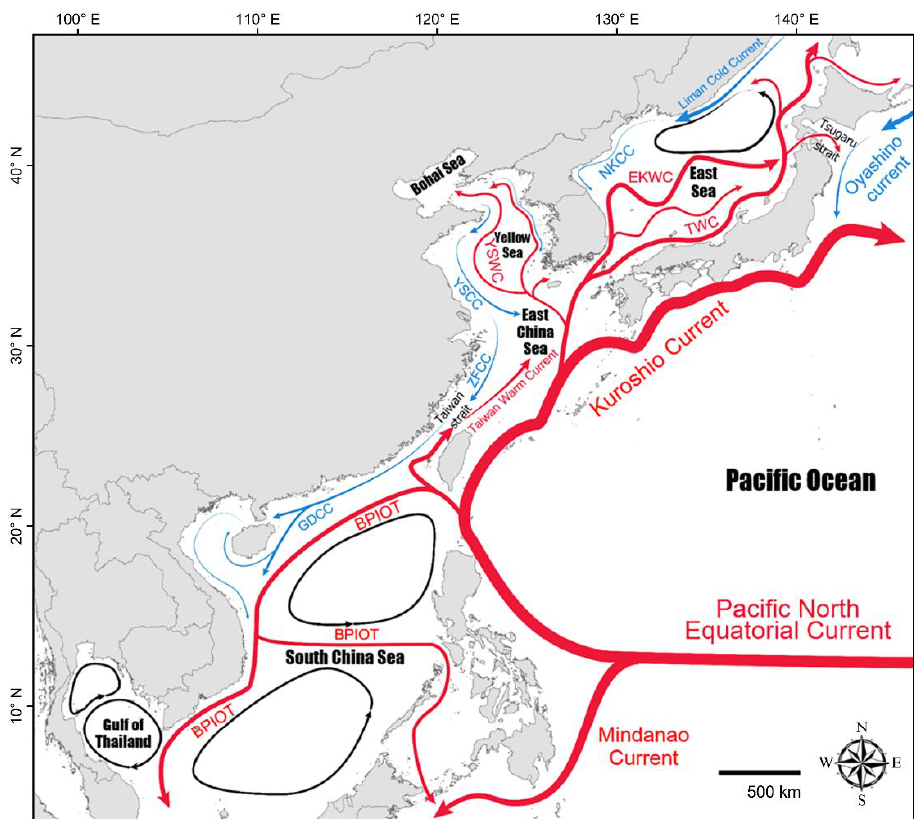
Figure 4. Topography and typical current patterns in the North Pacific Ocean (with reference to References [61 – 63]). Red arrows indicate warm currents, blue arrows indicate cold currents, and black arrows indicate gyres. BPIOT, Branch of the Pacific-to-Indian Ocean Throughflow; EKWC, East Korean Warm Current; GDCC, Guangdong Coastal Current; NKCC, North Korea Cold Current; TWC, Tsushima Warm Current; YSCC, Yellow Sea Coastal Current; ZFCC, Zhejiang-Fujian Coastal Current.